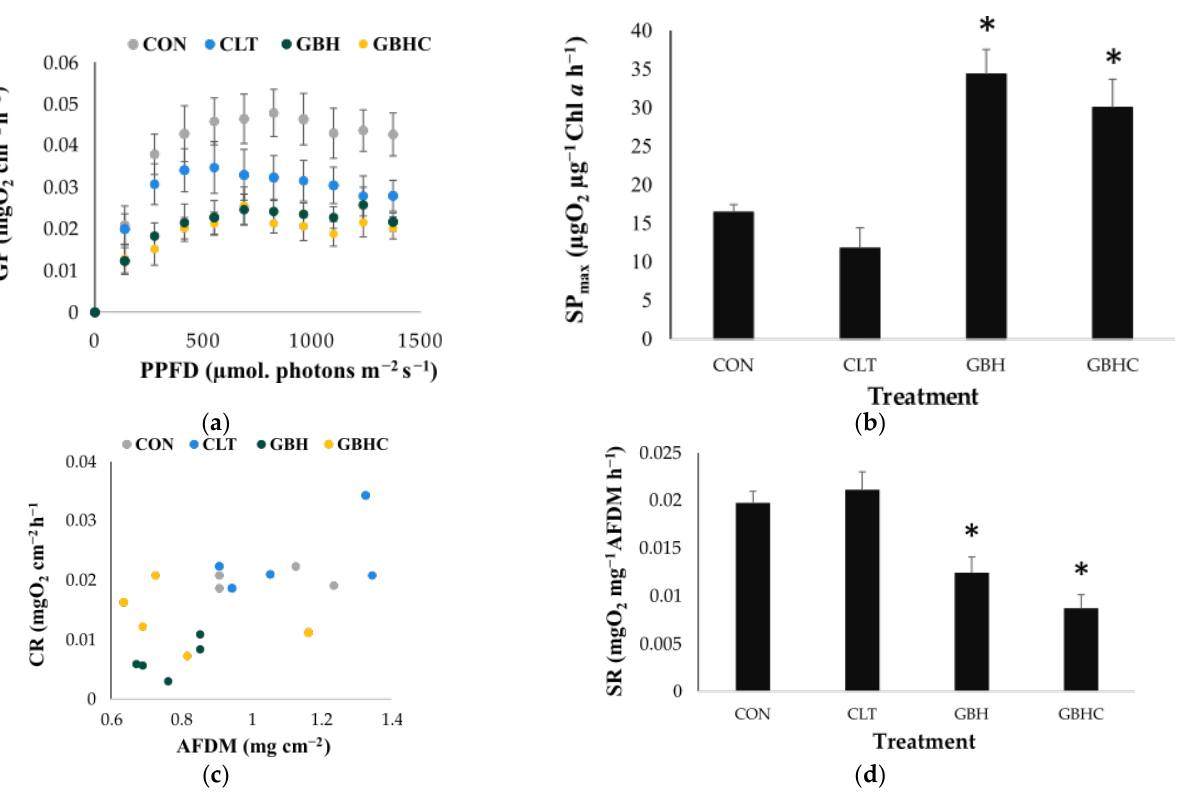
Figure 2. Impact of two herbicide treatments on the metabolic rate of phytobenthos: ( a ) areal rate of gross photosynthesis (GP) of phytobenthos; ( b ) biomass-specific maximum photosynthetic rate